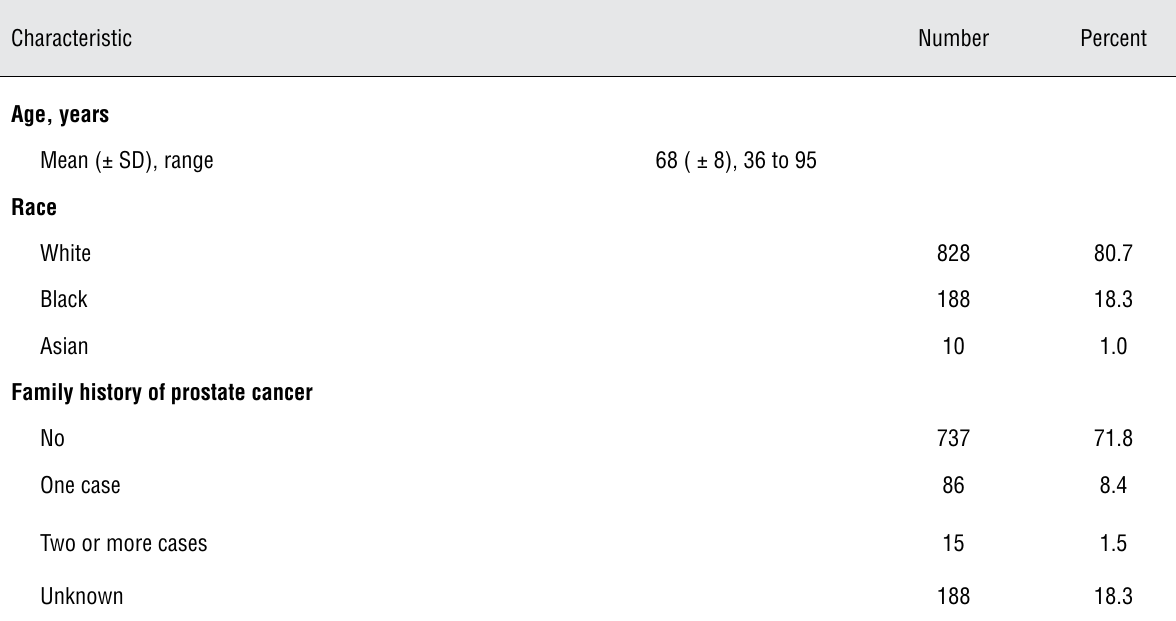
Table 1 - Demographic characteristics of patients attended at public